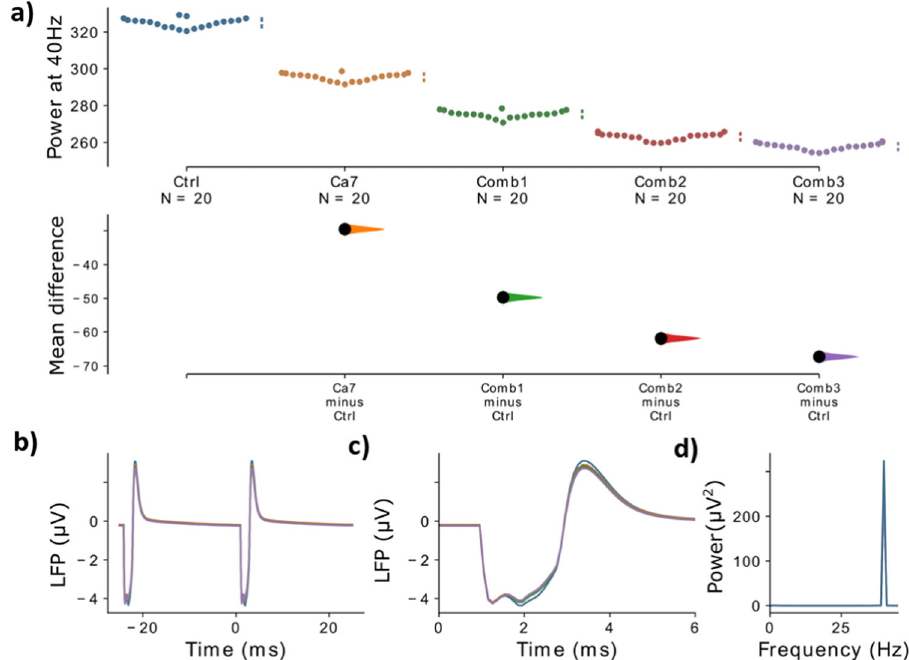
Fig. 4 Comparison of different combinations of variants against the control. a The mean difference for the comparisons of three variant combinations and the single variant with the strongest effect (Ca7) against the shared control are shown in the above Cumming estimation plot. The raw data is plotted on the upper axes. On the lower axes, mean differences are plotted as bootstrap sampling distributions. Each mean difference is depicted as a dot. Each 95% con fi dence interval is indicated by the ends of the vertical error bars. b The simulated LFP signal for the control network (blue), Ca7 (yellow), combination 1 (green), combination 2 (red) and combination 3 (purple) is shown, averaged over two consecutive gamma cycles. c The signals from b are presented with a zoom into the narrow time frame after the stimulus arrives at 0 ms. d The power spectral density (PSD) for the LFP signals from b . Note that in b – d the LFP signal is fi rst averaged over all ‘ subjects ’ and ‘ trials ’